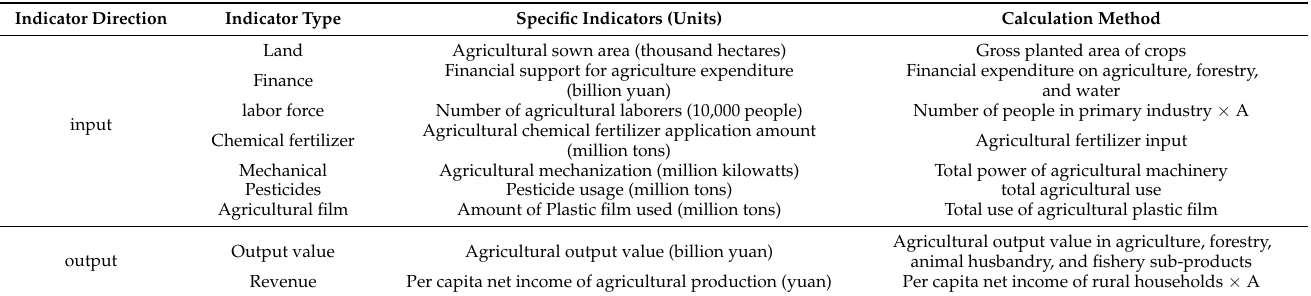
Table 1. Index system of agricultural production